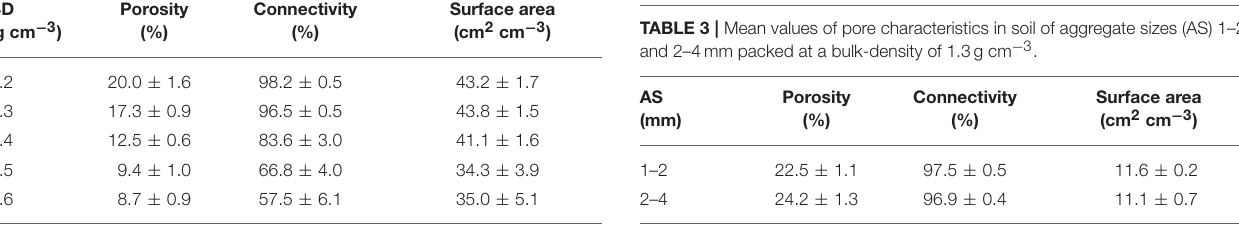
TABLE 2 | Mean values of soil pore characteristics packed at bulk-densities (BD) of 1.2, 1.3, 1.4, 1.5, 1.6g cm − 3 . BD (g cm − 3 ) TABLE 3 | Mean values of pore characteristics in soil of aggregate sizes (AS) 1–2